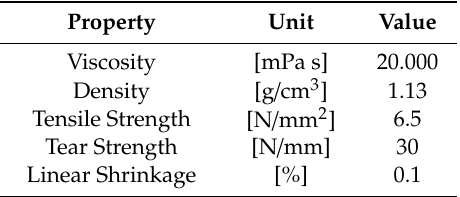
Figure 2. Schematic diagram outlining stages of the actuator fabrication process. ( a ) In the first molding step, the actuator is molded using 3D printed mold and core. ( b ) The bladders are obtained by demolding, and fiber reinforcing thread is wound along the length of the bladders. ( c )Then the anisotropic fabrics are wrapped on the bladders, and the junction is sewn to obtain the fabric-based actuator. ( d ) Insert the connector into the two ends of the extensor and the contractor, then insert the contractor into the extensor, seal and connect the junction is with glue. ( e ) Clamp two ends of the actuator with two rings. ( f ) Physical body of the soft actuator. Table 1. Performance index of silica gel at 23 °C.